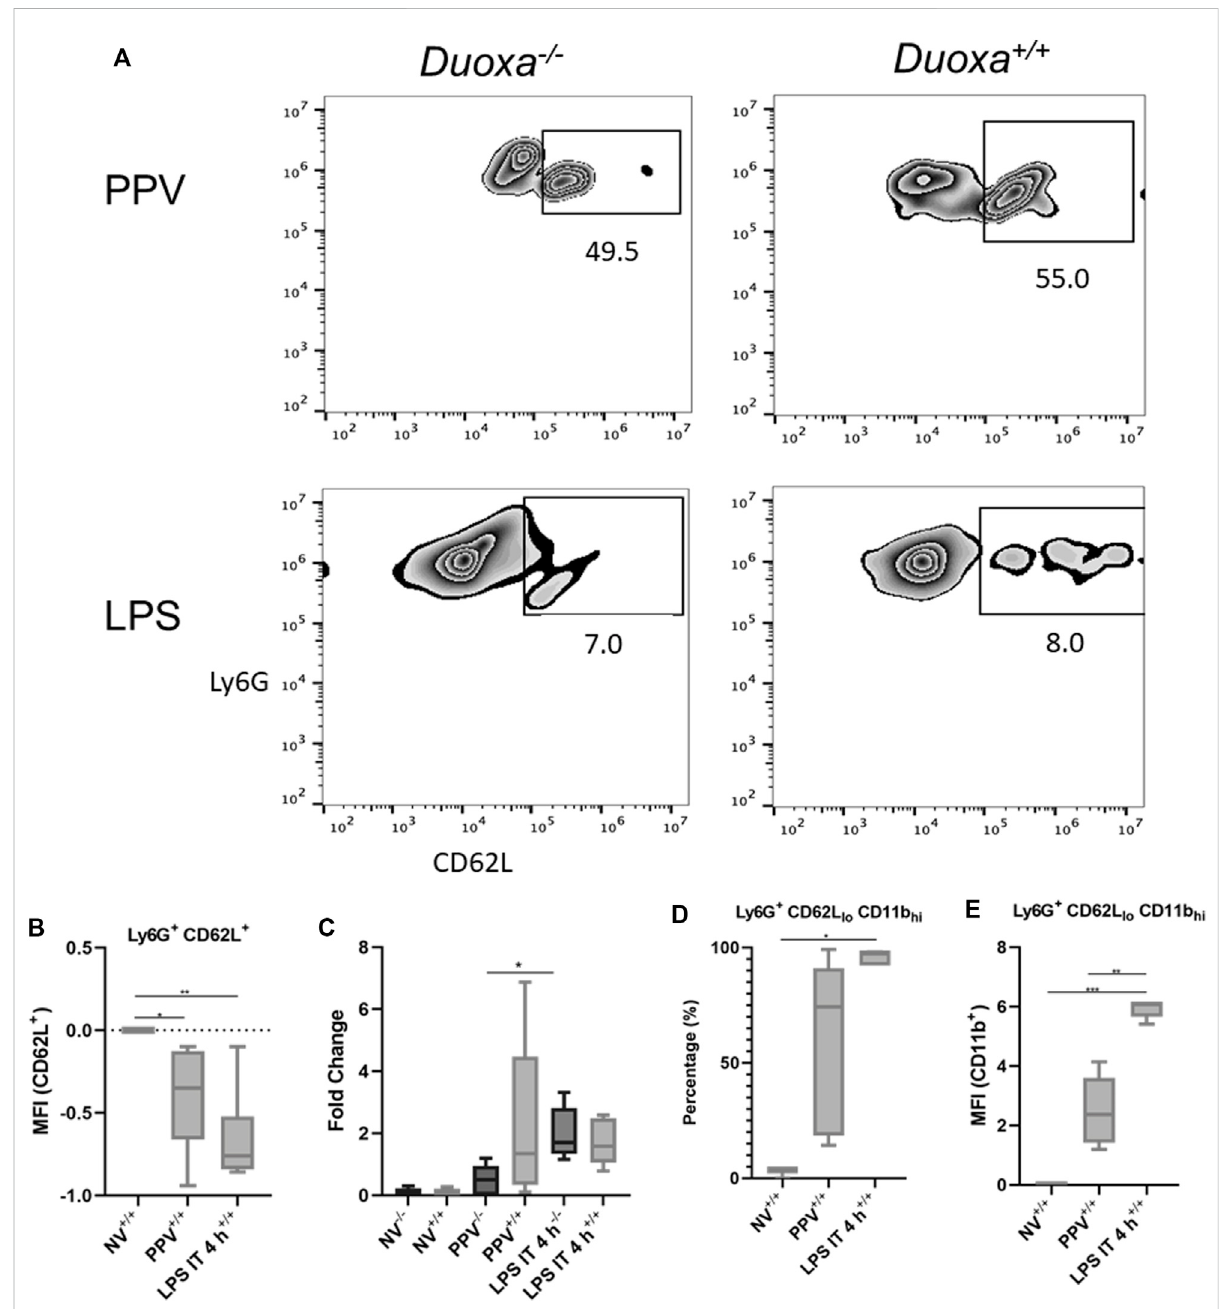
FIGURE 2 Duox does not impact L-selectin activation or shedding. Duoxa knockout mice ( − / − ) and wild-type mice (+/+) were subjected to injurious positive pressure ventilation (PPV) or instilled intratracheally with lipopolysaccharide (LPS)followedby isolation of neutrophils from bronchoalveolar lavage (BAL). Neutrophils were isolated using Ly6G antibody and subsequently phenotyped by fl ow cytometry using CD62L, CD11b antibodies, or both. (A) Populations of Ly6G + ( y -axis), CD62L + ( x -axis) neutrophils in Duoxa knockout ( − / − ) compared to wild-type (+/+) mice after exposure to PPV or LPS. (B) Mean fl uorescence intensity (MFI) of Ly6G + , CD62L + neutrophils in PPV- or LPS-exposed mice compared to non-ventilated, untreated controls (*, p = .040, **, p = .003). (C) Protein levels of CD62L by ELISA from BAL fl uid in non-ventilated, untreated controls compared to PPV-andLPS-treatedmice.Fold-changeinproteinlevelsfromnon-ventilated,untreatedcontrolsisshown.SheddingofCD62Lligandwashigherin wild-type (+/+) versus Duoxa knockout ( − / − ) mice after PPV (*, p = .010) but not after LPS exposure ( p = .164). (D) Percentage of Ly6G + BAL neutrophils expressing low CD62L and high CD11b levels isolated by fl ow cytometry after no exposure (NV), PPV, or LPS. (*, p = .007 for LPS versus NV). (E) MFIofBALneutrophilsgatedforCD62L lo andCD11b hi by fl owcytometryinnon-ventilated,untreatedwild-typemice(NV)comparedtoPPV- and LPS-exposed mice. (**, p = .001; ***, p =